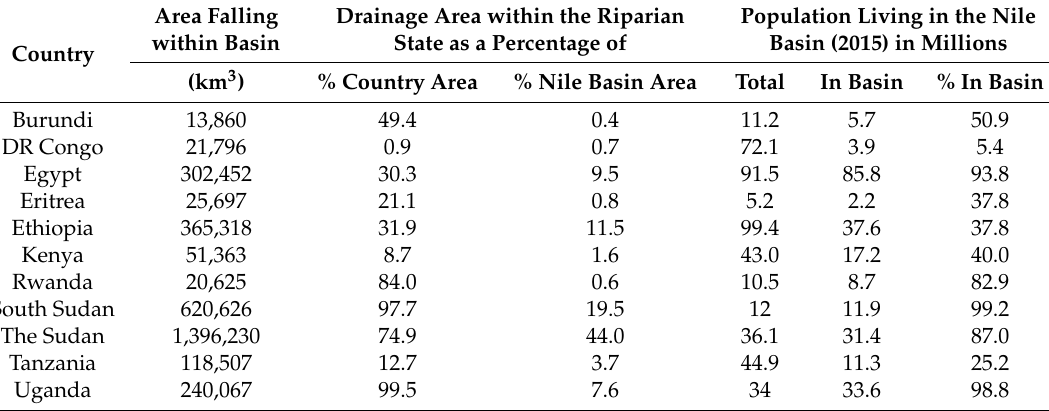
Table 2. Nile Basin data on drainage basin area within the various riparian states and the population living within the Nile basin (Area falling within the Nile Basin, Contribution of riparian states to the Nile Basin water, % of drainage area in the Basin States, Total Population, and the percentage of the population living in the basin area). Source: Nile Basin Initiative (NBI) (2012) for the data on the area within the Nile Basin as a percentage of the country area and area within the basin as a percentage of the Nile Basin area ([24], p. 13). NBI (2016) for the 2015 population data and the population within the basin area ([24], p. 53). DR: Democratic